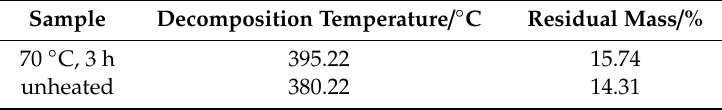
Figure 7. TGA curves of the before after 70 °C 3h heat treatment films. Table 4. TGA data of the hybrid-cured films.